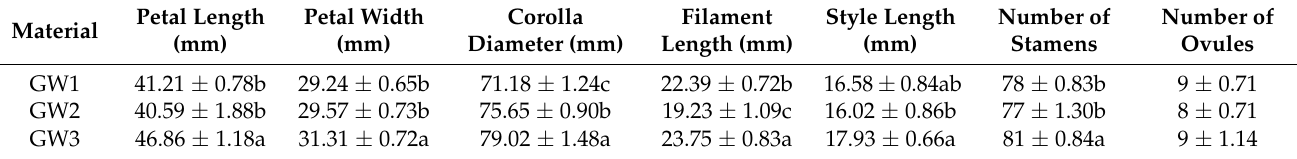
Table 2. Morphology of the flower organs of C. weiningensis